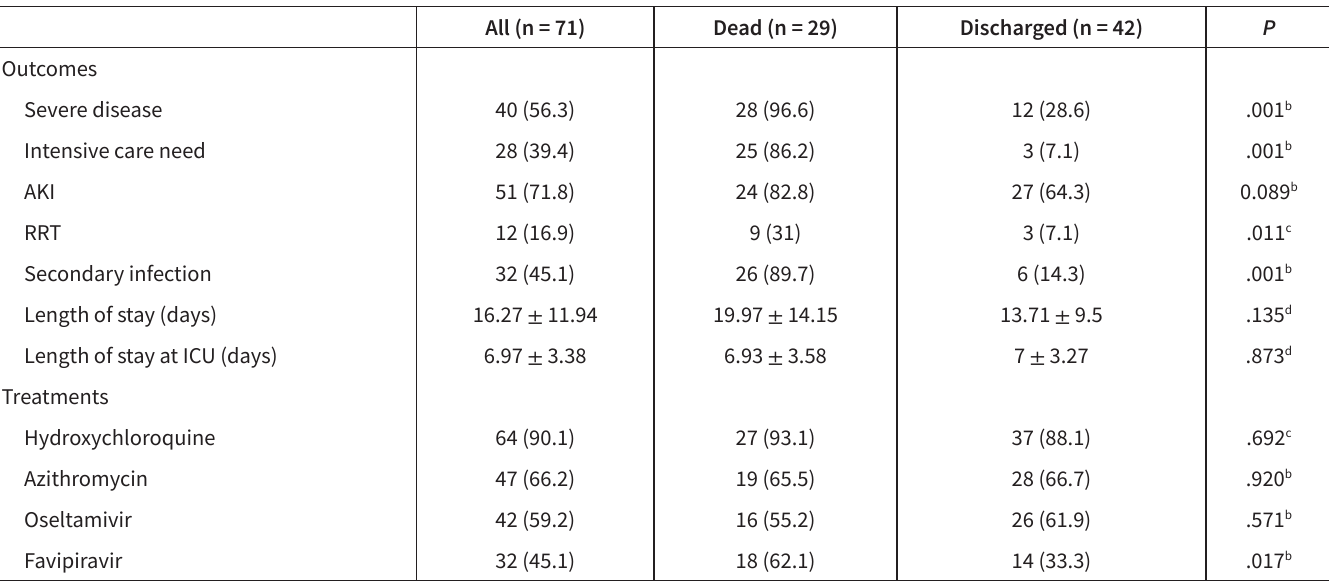
Table 1. Comparison of the Patient’ Characteristics Based on Mortality ( Continued